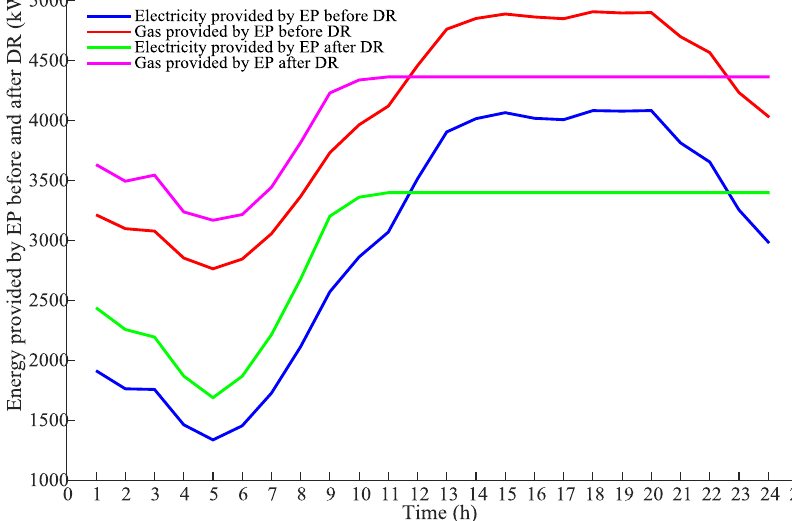
Figure 6. Real time energy supply by the energy provider (EP) before and after DR.